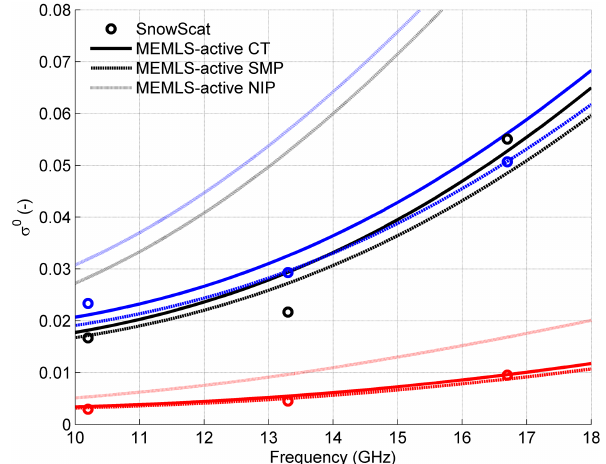
Figure 7. σ 0 at incidence angle 50 ◦ measured by SnowScat (cir- cles) and modeled by MEMLS3&a with CT input (lines) for best fit parameters: s s0,h = 0 . 75 · s 0,h ; s s0,v = 0 . 75 · s 0,v ; q = 0 . 15; and m = 0 . 1. Colors represent polarization, with vv – black, hh – blue and hv – red.